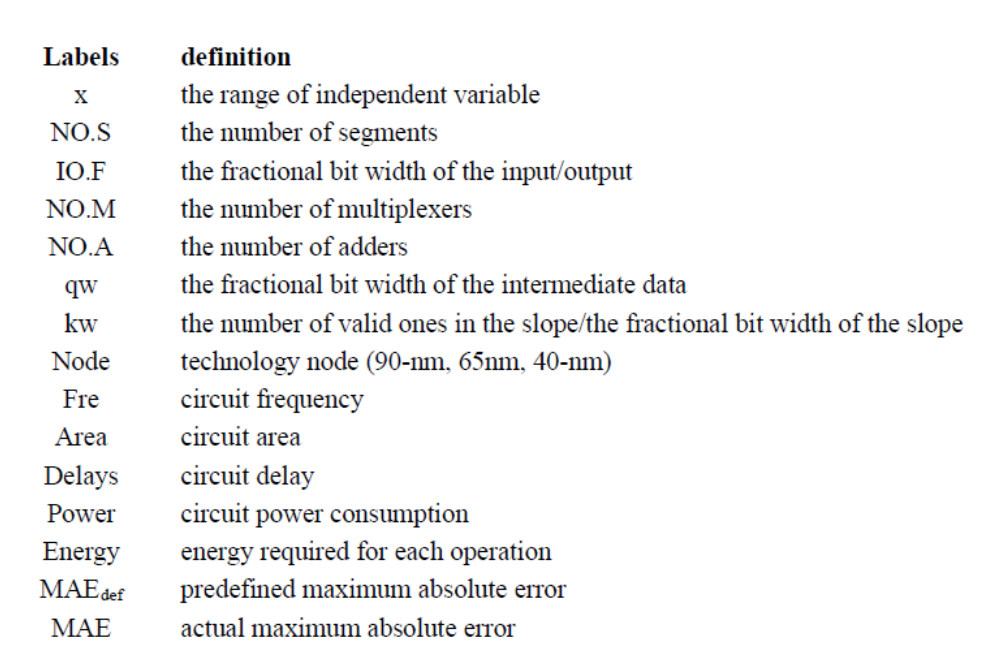
Figure 7. Definitions of labels in the Tables 5–9.